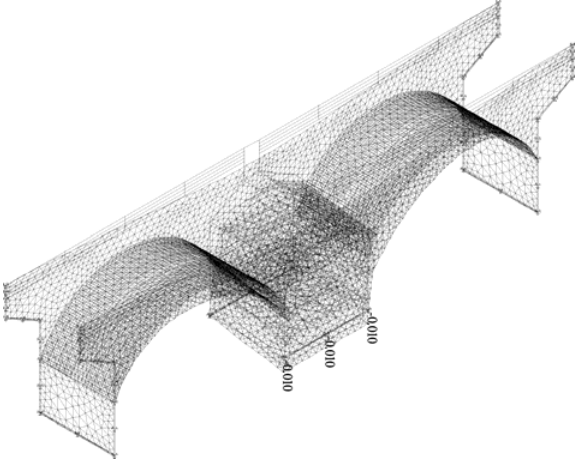
Fig 5. Diagram of bridge span deformations with angular rotation in pier footing bottom